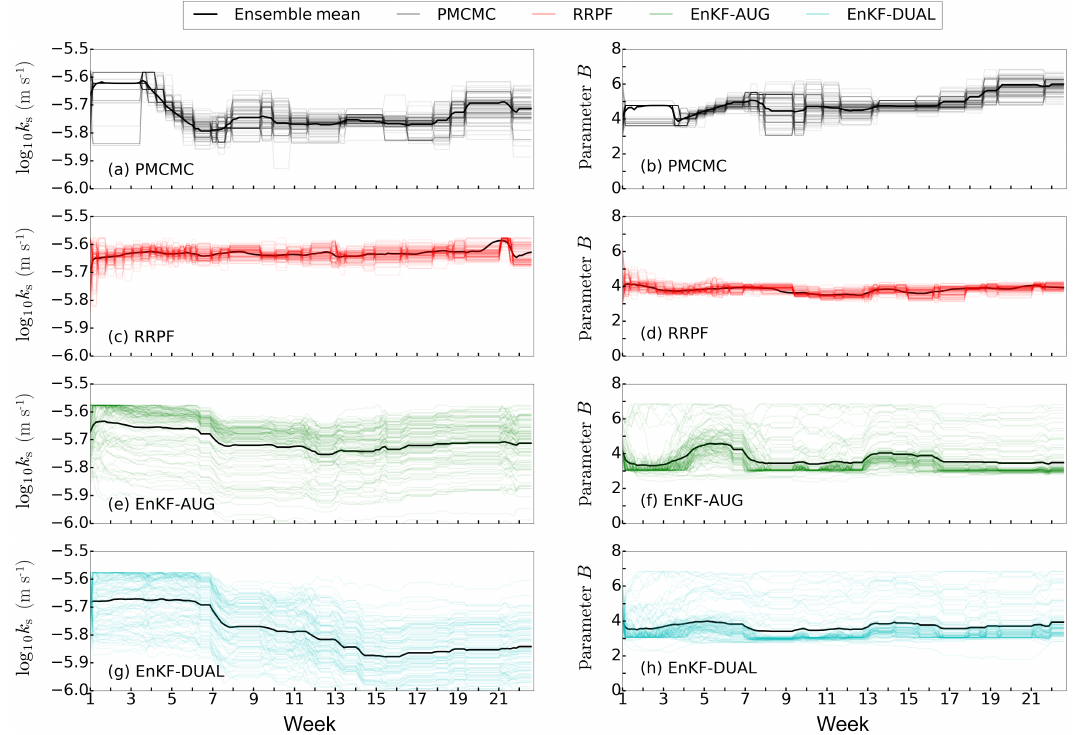
Figure 11. Sampled trajectories of the N = 100 ensemble members of the saturated hydraulic conductivity (log 10 k s in ms − 1 ) at 50cm depth (a, c, e, g) and soil hydraulic parameter B at 50cm depth (b, d, f, h) of CLM during the 5-month assimilation period of weeks 1 to 22 using (a–b) PMCMC (grey) (c–d) RRPF (red), (e–f) EnKF-AUG (green), and (g–h) EnKF-DUAL (cyan). The solid black line signifies the evolution of the ensemble mean values of log 10 k s and B . Please note that log 10 k s (in log 10 (ms − 1 )) and parameter B are derived from the sand, clay, and organic matter fractions of each soil layer, which are estimated during the assimilation